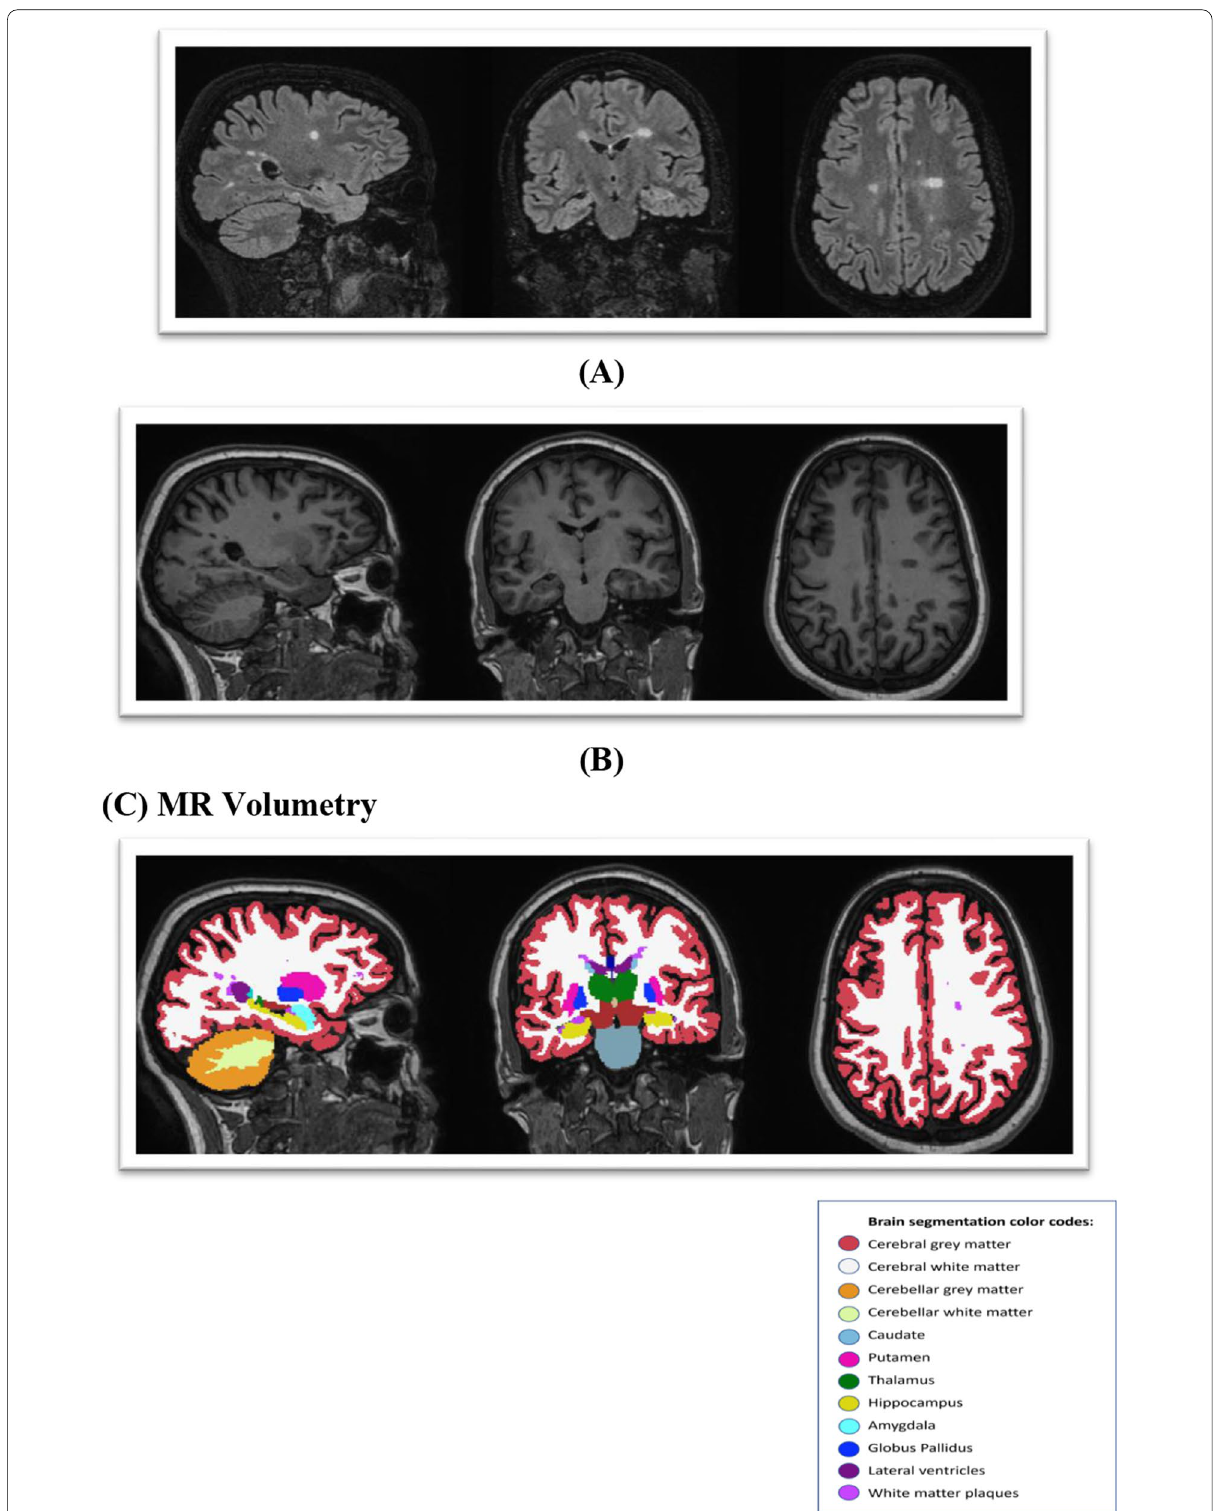
Fig. 12 29 year old male diagnosed with MS 8years ago with EDSS (4) with features of cognitive impairment. ( A ) 3D FLAIR images showing multiple foci and patchy areas of high signal intensity implicating the peri ventricular and juxta cortical white matter. ( B ) 3D T1 images showing multiple foci and patchy areas of slightly low signal intensity implicating the peri ventricular and juxta cortical white matter. ( C ) MR